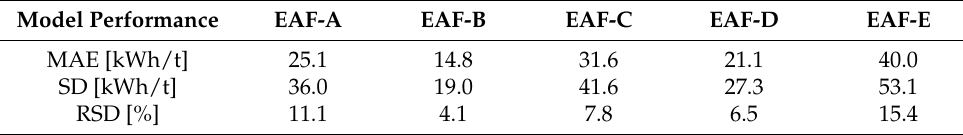
Table 4. Results of the Köhle formula on the investigated furnaces. Model